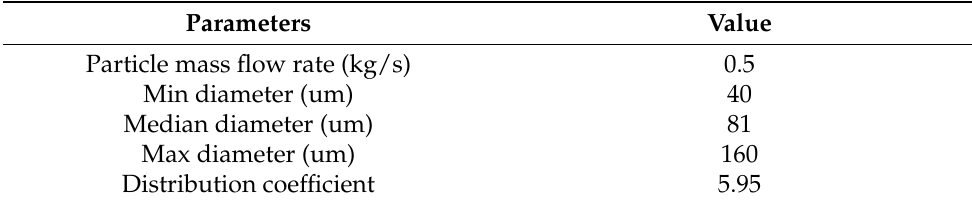
Table 2. Discrete phase main